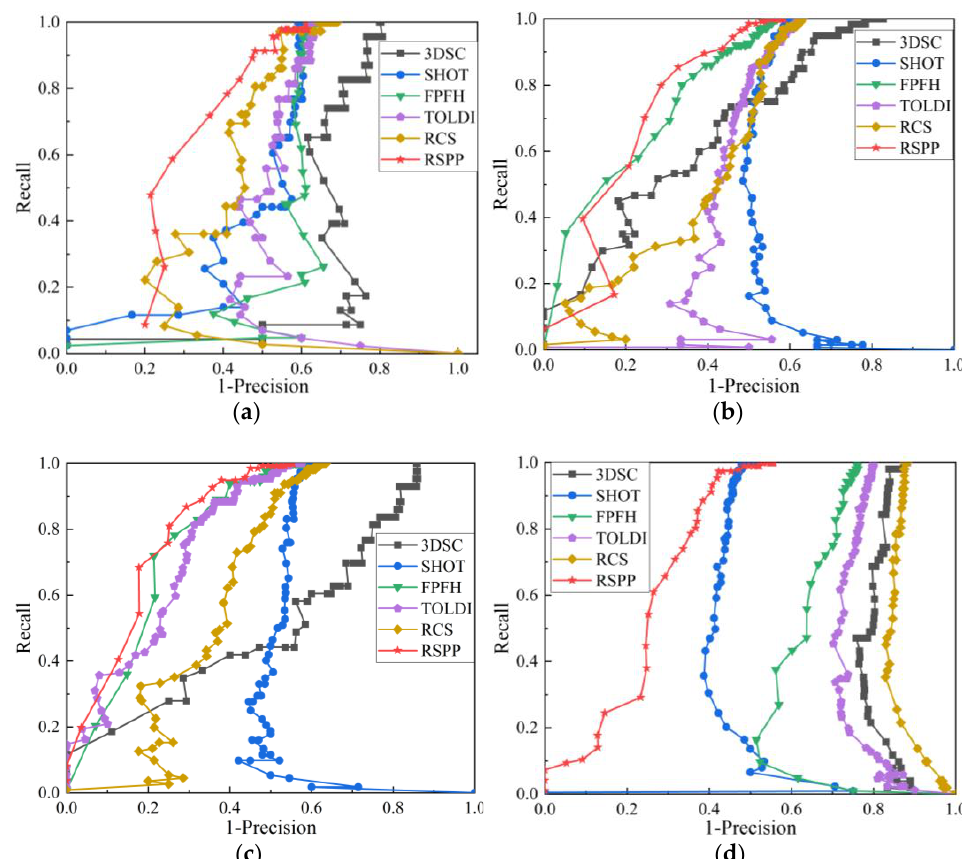
Figure 9. RP curves of different feature descriptors under 0.25 mr Gaussian noise: ( a ) RP curve of Bunny dataset; ( b ) RP curve of Buddha dataset; ( c ) RP curve of Dragon dataset; ( d ) RP curve of Armadillo dataset.